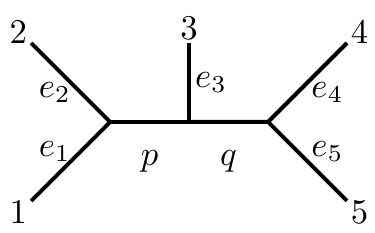
Figure 1 . Caterpillar tree with 5 leaves and edge lengths labeled by e i , p and q .